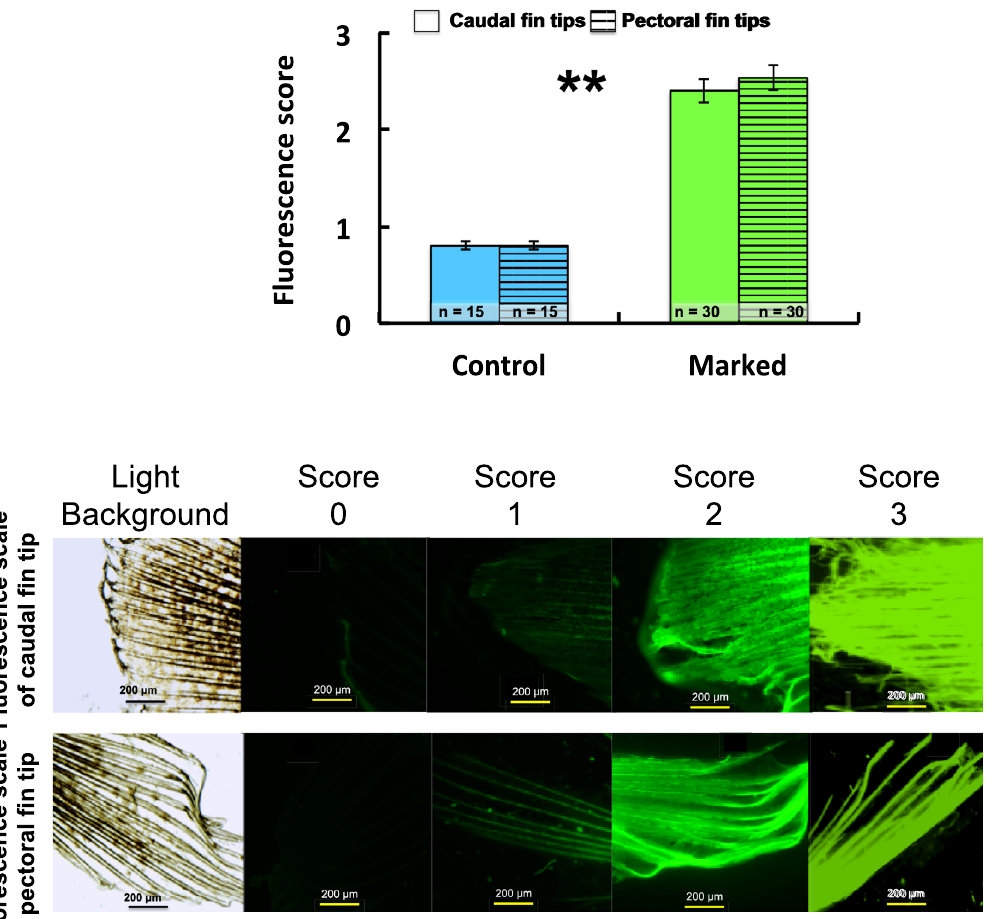
Figure 6. Epifluorescence scores of caudal and pectoral fins of marked and control glass eels. ( a ) Means of the epifluorescence scores assigned to caudal and pectoral fin tips of marked and control glass eels. *: significant difference between marked and control glass eels for a type of fin. ( b ) Epifluorescence scores scale 0–3 (0, no fluorescence; 1, weak autofluorescence around fin rays and at the edge of the fin; 2, bright and heterogeneous fluorescence of alizarin stain on fin rays and tissue; 3, very bright and homogeneous fluorescence of alizarin stain on fin